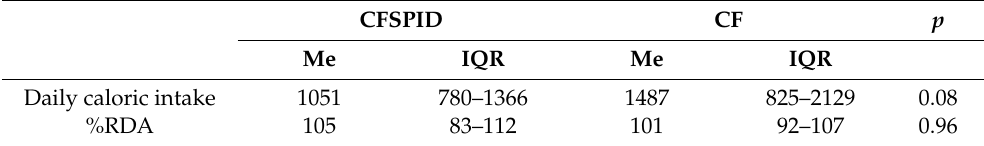
Table 7. The daily consumption of calories in the CFSPID and CF groups based on three-day food